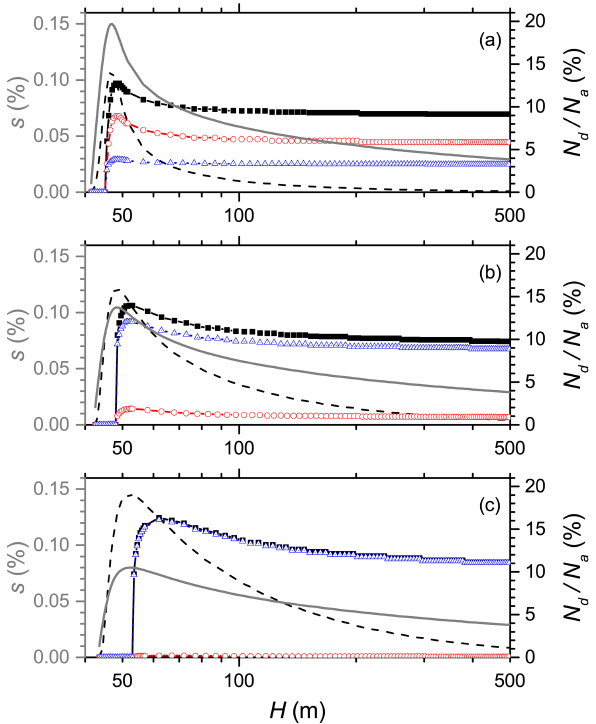
Figure 9. Supersaturation (left axis, grey) and aerosol activated fraction during the simulation (right axis) for the Ext 2 population = 0 . 06 (a) , and the HP 5 , 5 case study, for W = 0 . 5ms − 1 and κ p eff = 0 . 14 (b) and κ p = 0 . 25 (c) . The cloud droplet concentra- κ p eff eff tion was estimated as N d,eq (dashed line), and N d,neq for the popu- lation (black solid line, close squares) and hygroscopic groups with κ p = 0 . 04 (red dashed line, open circles) and κ p = 0 . 30 (blue dotted line, open upward-facing